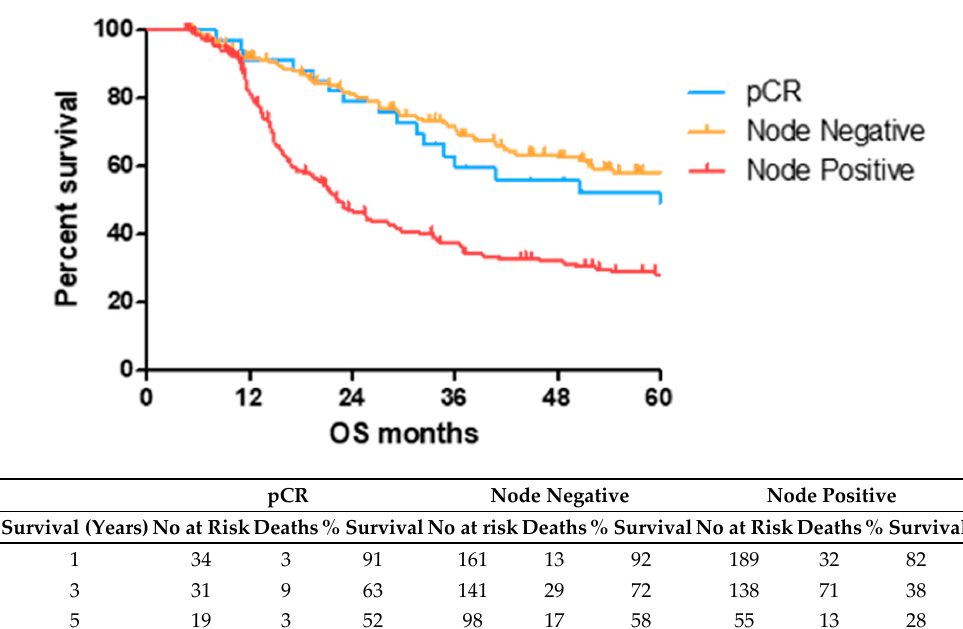
Figure 1. Lower TRG scores and node negativity are associated with longer overall survival time. A cohort of 80 EAC/EGJ patients was divided according to low (TRG1–2) or high (TRG3–5) TRG scores ( a ), or nodal status and pCR ( b ) and OS time in months was visualized using a Kaplan–Meier curve. Log- rank (Mantel–Cox) tests were performed to assess median survival time differences between groups. TRG = Tumor Regression Grade, OS = Overall Survival, pCR = Pathological Complete Response.